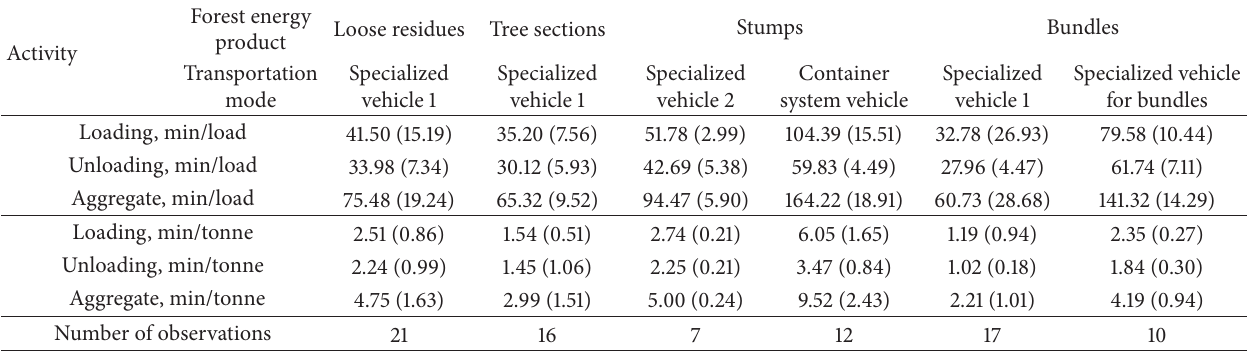
Table 3: Mean time consumption in minutes per load and tonne (standard deviations in parentheses).